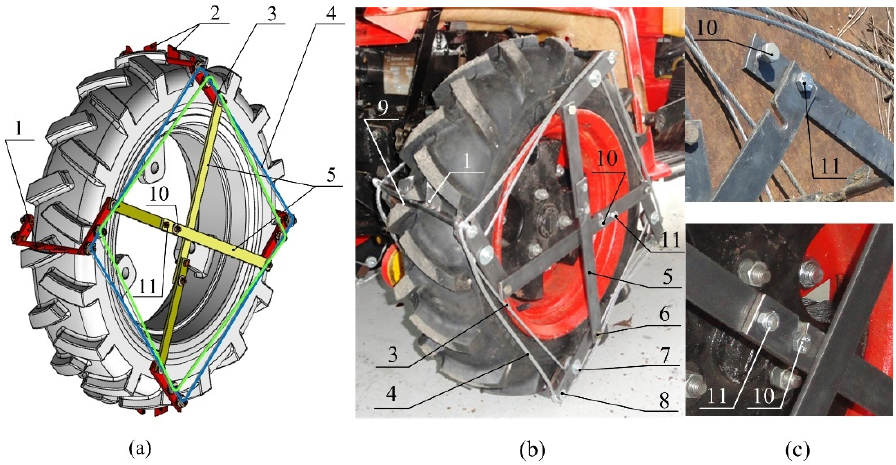
Figure 1. Principle of the spike tires: ( a ) design (spikes in the protruded position), ( b ) application on tractor wheel (spikes in the base position), and ( c ) principle of the control lever mechanism. 1—spike segment; 2—spikes; 3—control wire strand; 4—carrier wire strand; 5—control lever mechanism; 6, 11—pins of control lever mechanism; 7—pin for control wire strand; 8—pin for carrier wire strand; 9—groove in tire; 10—safety screw.